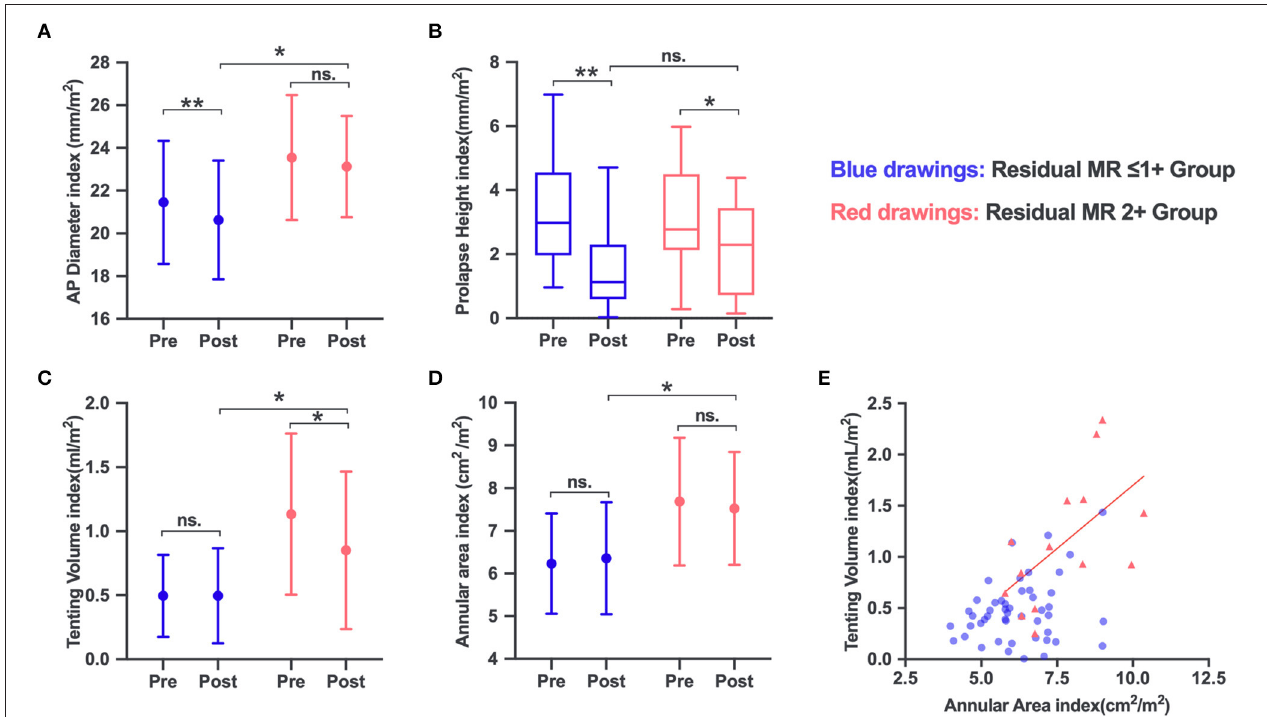
FIGURE 2 | Changes in mitral valve (MV) anatomic parameters in the residual MR 2 + and residual ≤ 1 + groups: AP diameter (A) , prolapse height (B) , tenting volume (C) , and annular area (D) . (E) The annular area increased in parallel with the tenting volume increase in the residual MR 2 + group, but not in the residual ≤ 1 + group. ns, no significance. * P < 0.05; ** P < 0.001.